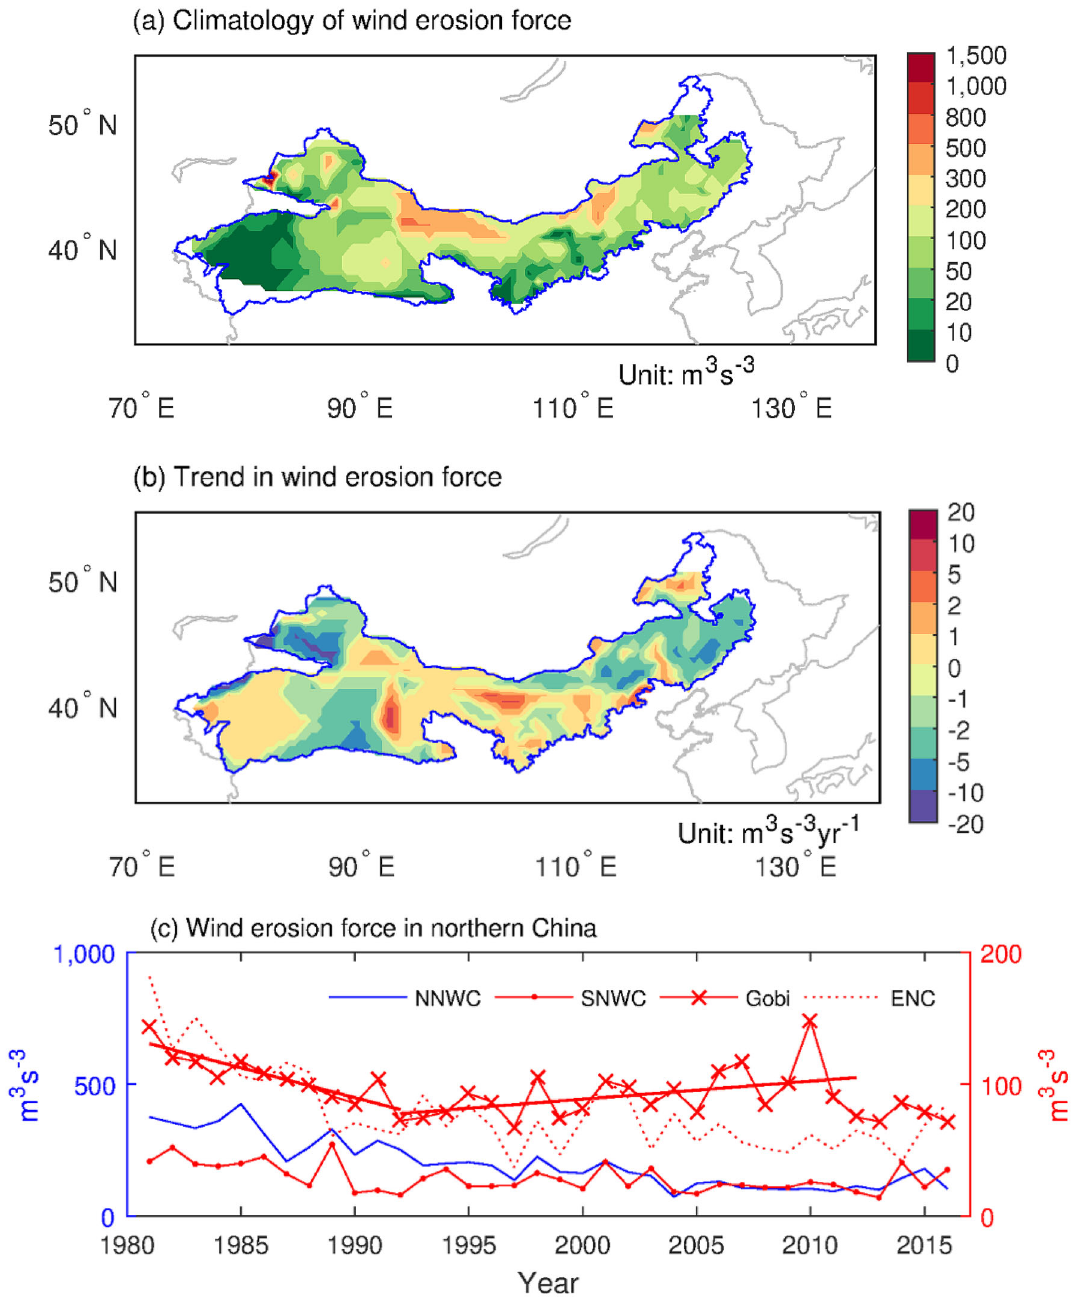
Fig. 4 Spatial distribution of climatological wind erosion force ( a ) and trend in wind erosion force ( b ) in northern China during spring from 1981 to 2016. Segment ( c ) shows the time series of spring wind erosion force in the southern Northwest China (SNWC),